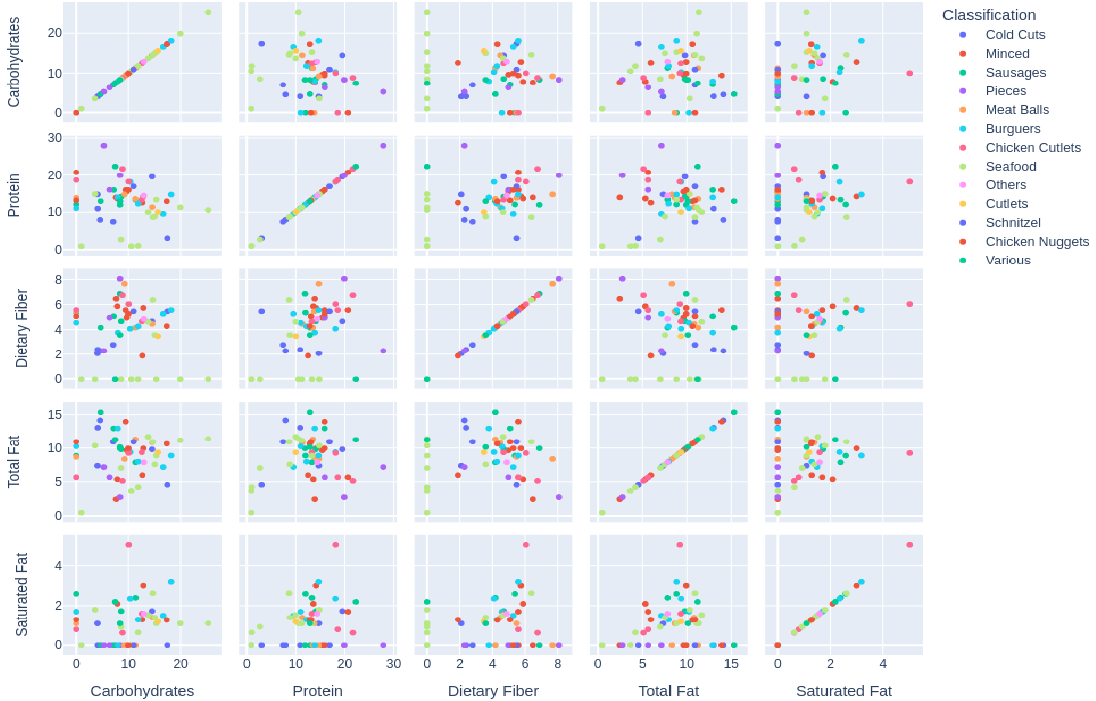
Figure 2. Scatterplot exposing the proportions for pairs of analyzed nutrients for each meat substitute category. Numbers’ units are represented in g/100 g.